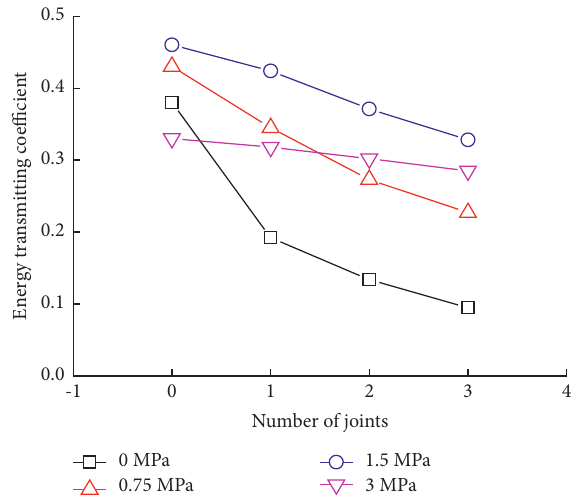
Figure 15: Influence of joint number on stress wave energy transmitting coefficients under different static